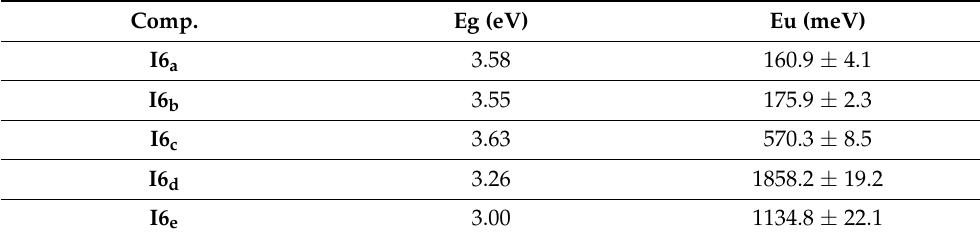
Table 2. Values of the energy gap (E g ) and Urbach energy (E U ) for analogs series I6 a–e. Comp.